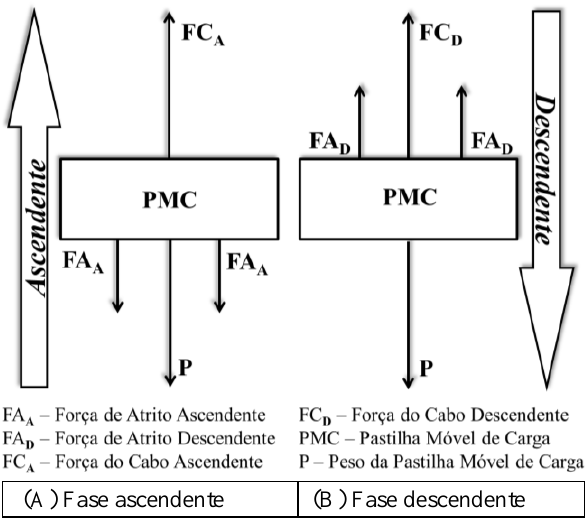
Figura 3 . Diagrama de corpo livre da pastilha representadas por setas pretas. A direção do movimento da PMC é representada por setas brancas largas.